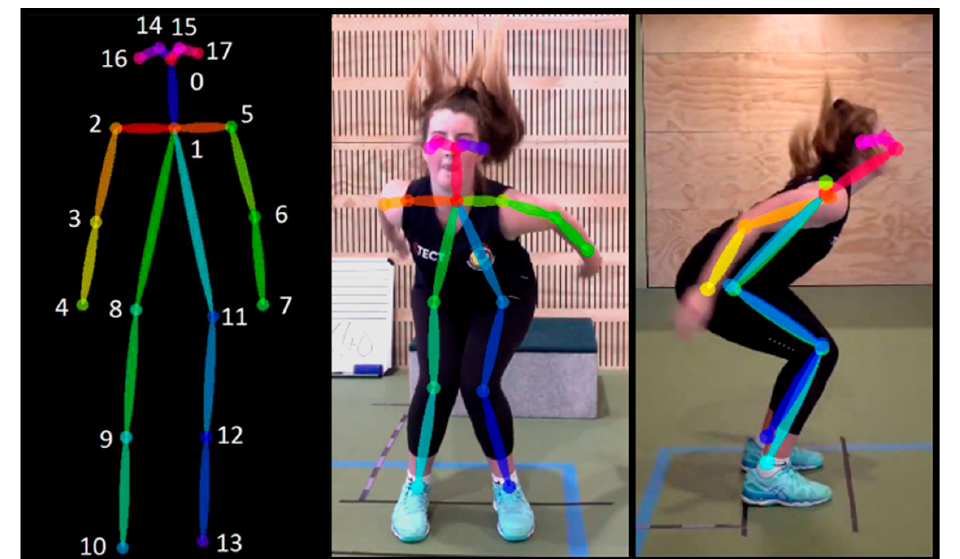
Figure 3. OpenPose’s COCO 18-points model keypoint positions (left image) [16] and example of a frontal (middle image) and lateral (right image) view processed video at the maximal knee flexion key frame. Table 3. Measurements extracted from key frames and used as kinematic features.